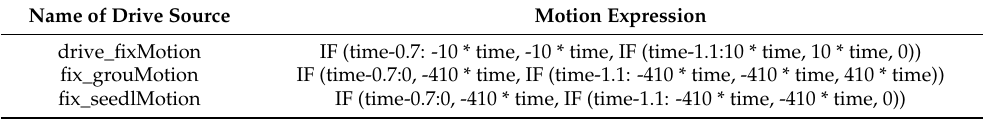
Table 3. Motion equations of the drive source.